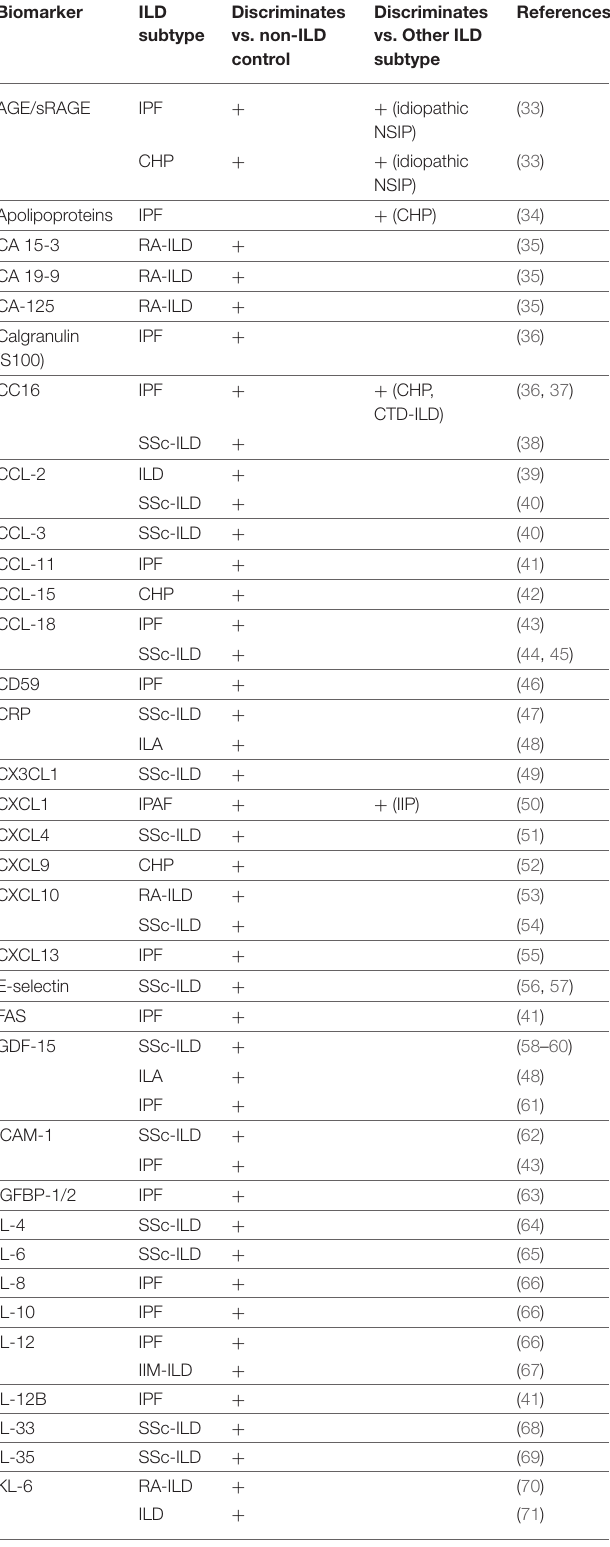
TABLE 1 | Diagnostic ILD plasma/serum